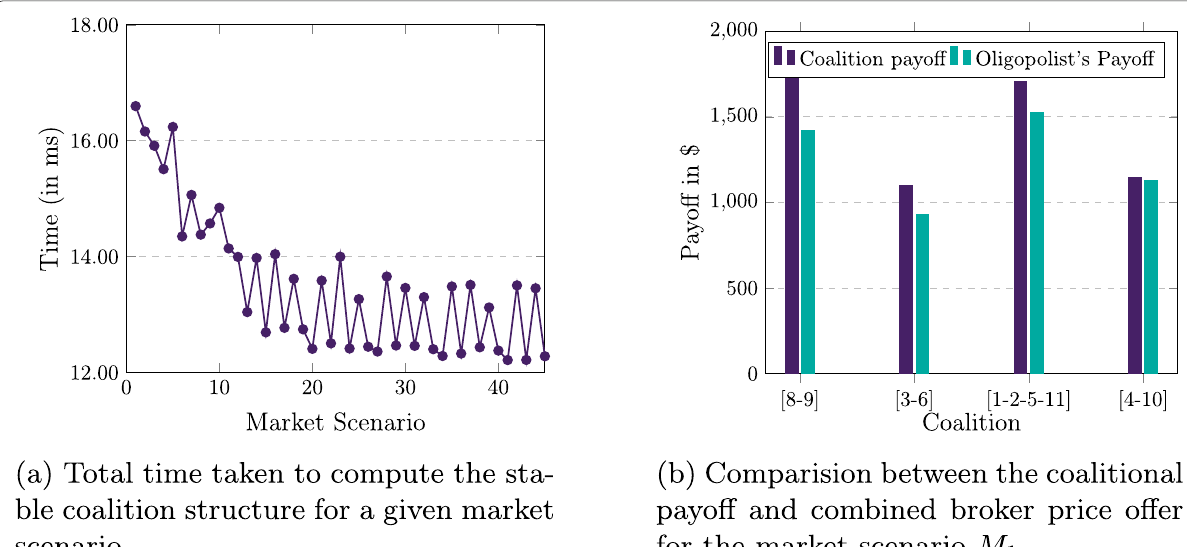
Fig. 4 Left panel depicts time taken to compute stable coalition structure. Right panel compares the payoff from the coalition and the oligopolist in the first market